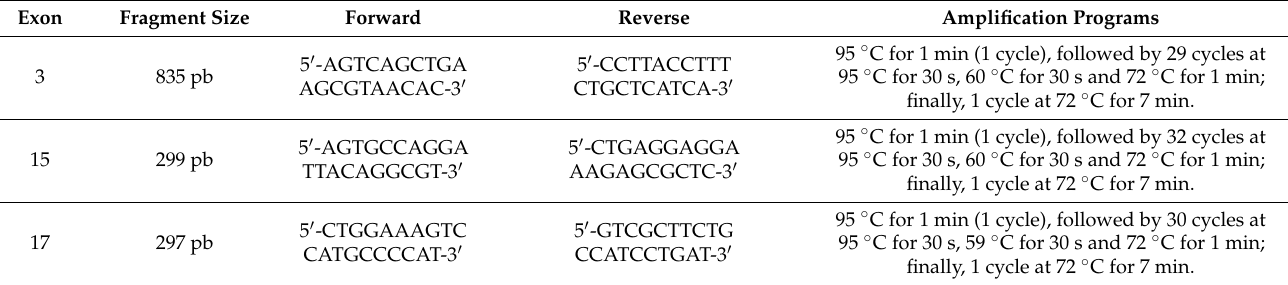
Table 1. Primers for the amplification of exons 3, 15 and 17 of the HR